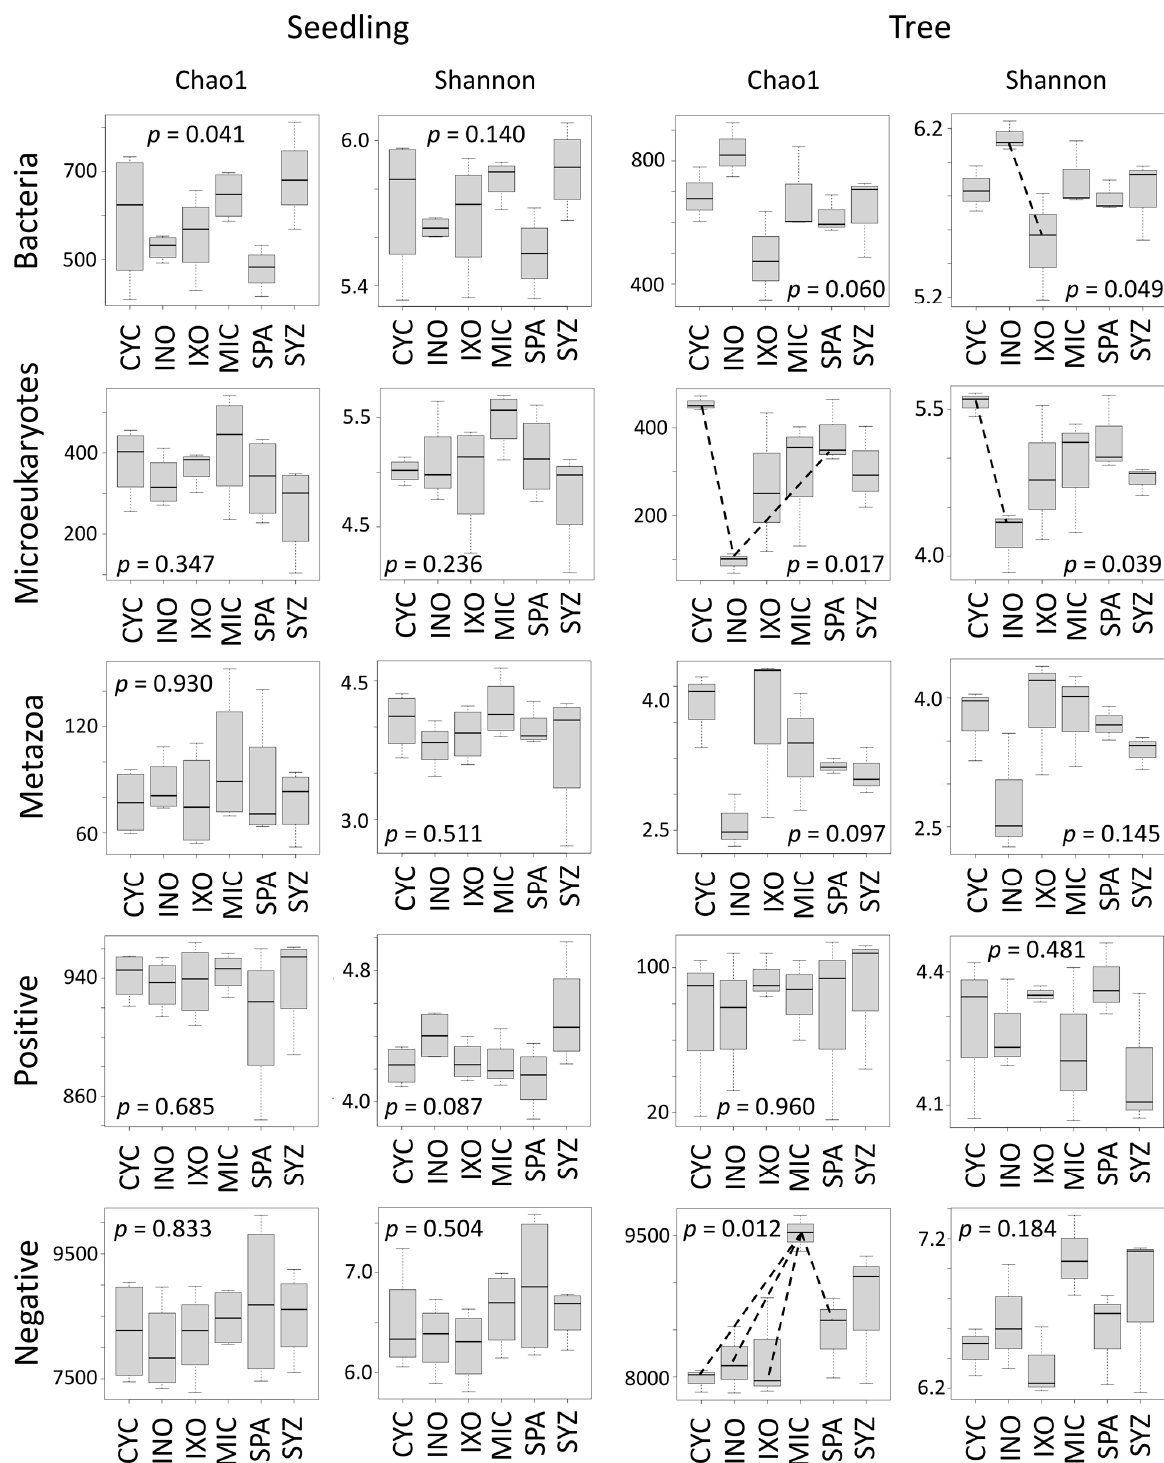
Figure 3. Shannon and Chao1 metrics in seedling and tree stages. CYC: Cyclophyllum barbatum , INO: Inocarpus fagifer , IXO: Ixora mooreensis , MIC: Miconia calvescens , SPA: Spathodea campanulata , SYZ: Syzygium malaccense . Dashed lines indicate significant pairwise